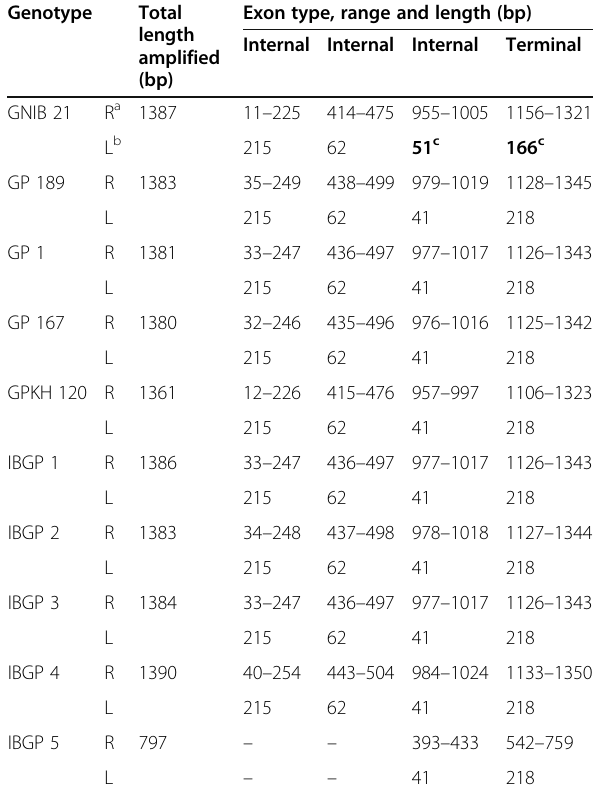
Table 2 Gene prediction for LprTFL in ten genotypes of Indian bean using GeneMark